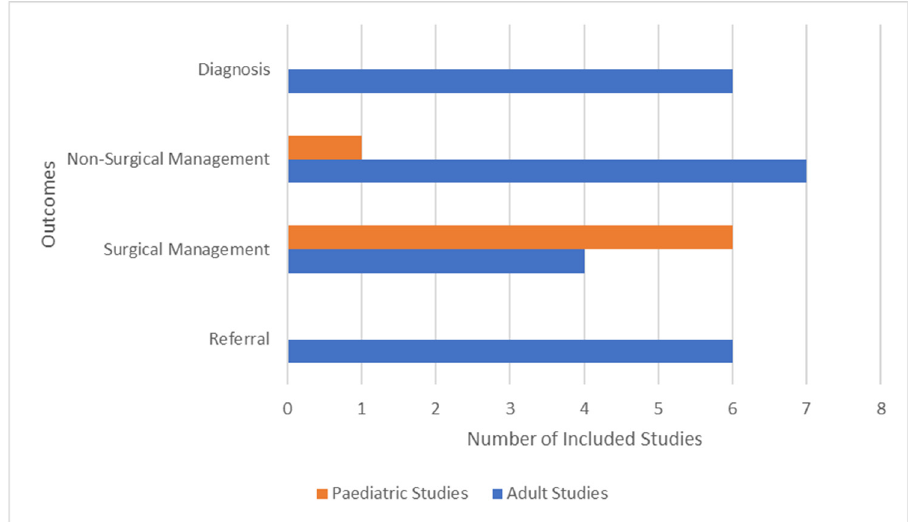
Figure 2. Bar chart characterizing the number of included paediatric (orange) and adult (blue) studies that explored diagnosis, non-surgical management, surgical management, and referral as their key outcomes.